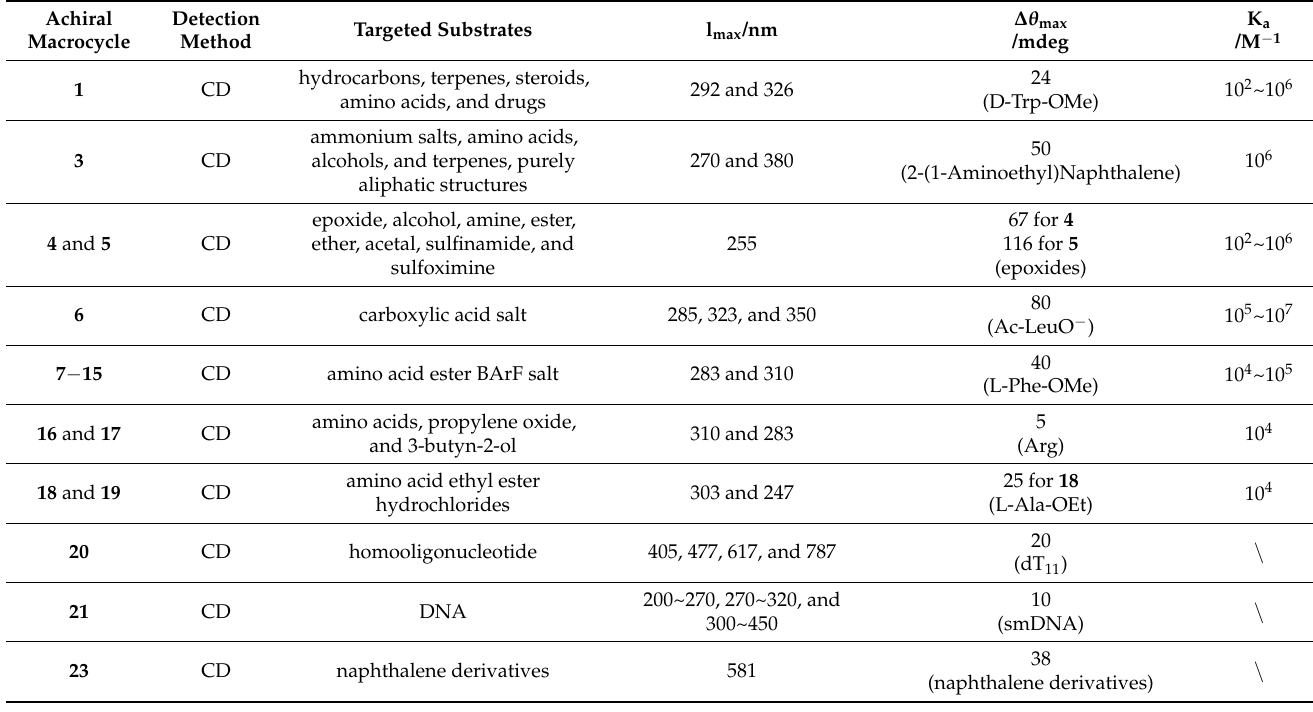
Table 1. The detection method, targeted substrates, CD signal peak wavelength ( λ max ), maximum CD signal value ( ∆ θ max ), and binding constants ( K a ) obtained with achiral macrocyclic chiral